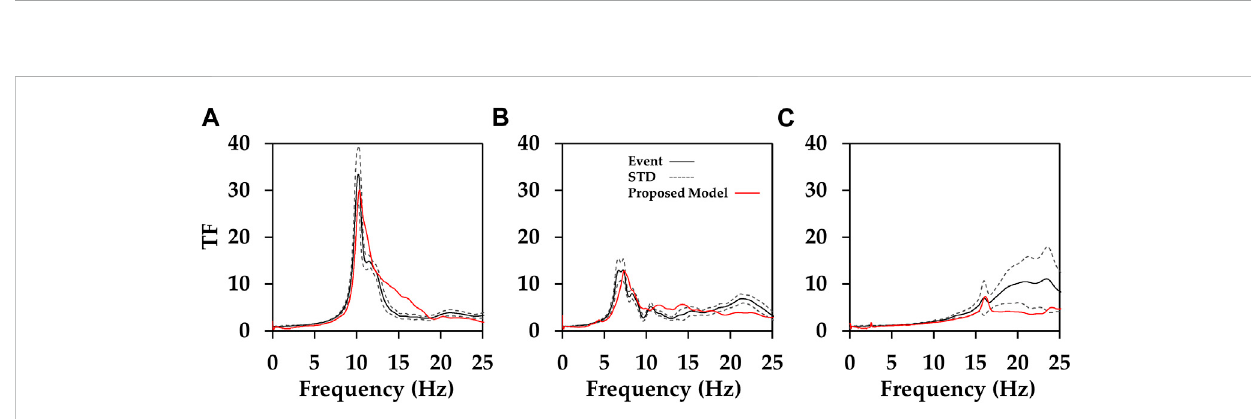
Comparison of transfer functions of events (black solid line) and proposed model (red solid line): stations (A) HAMB, (B) IMWB, and (C)